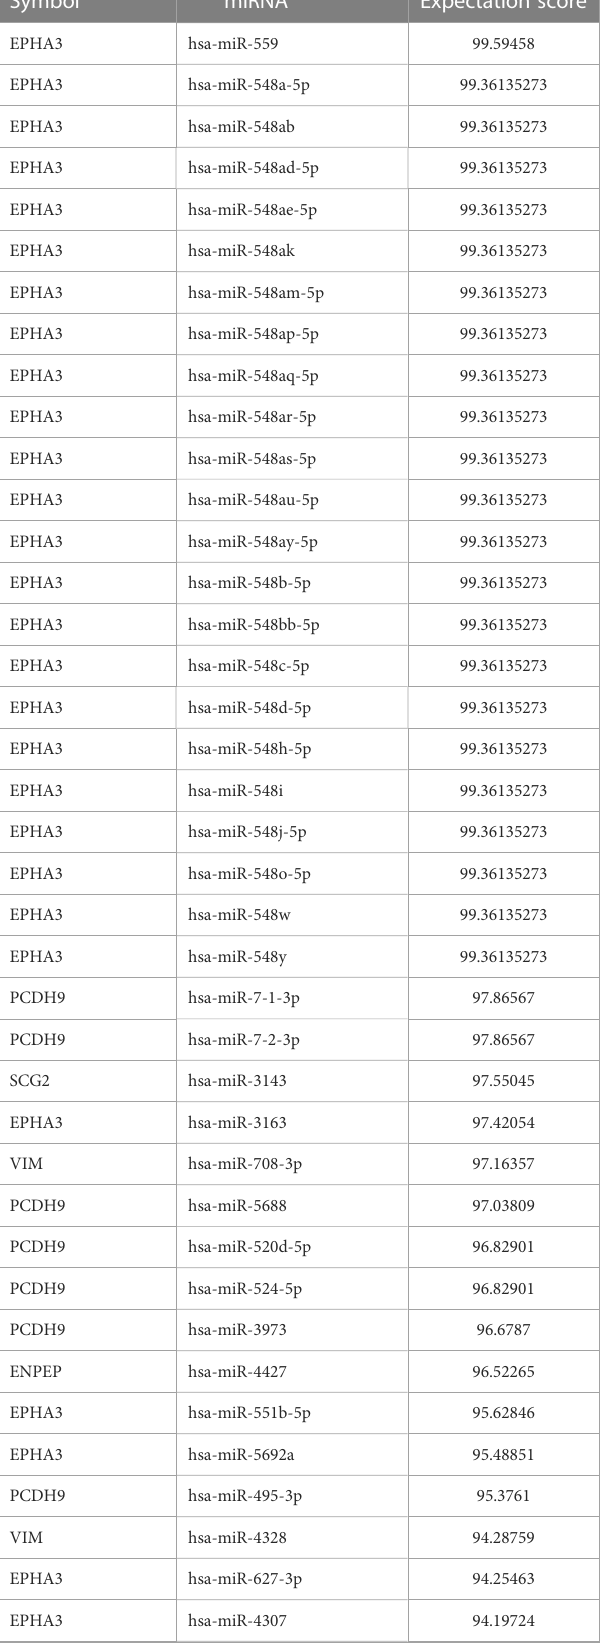
TABLE 2 Continued Symbol miRNA Expectation